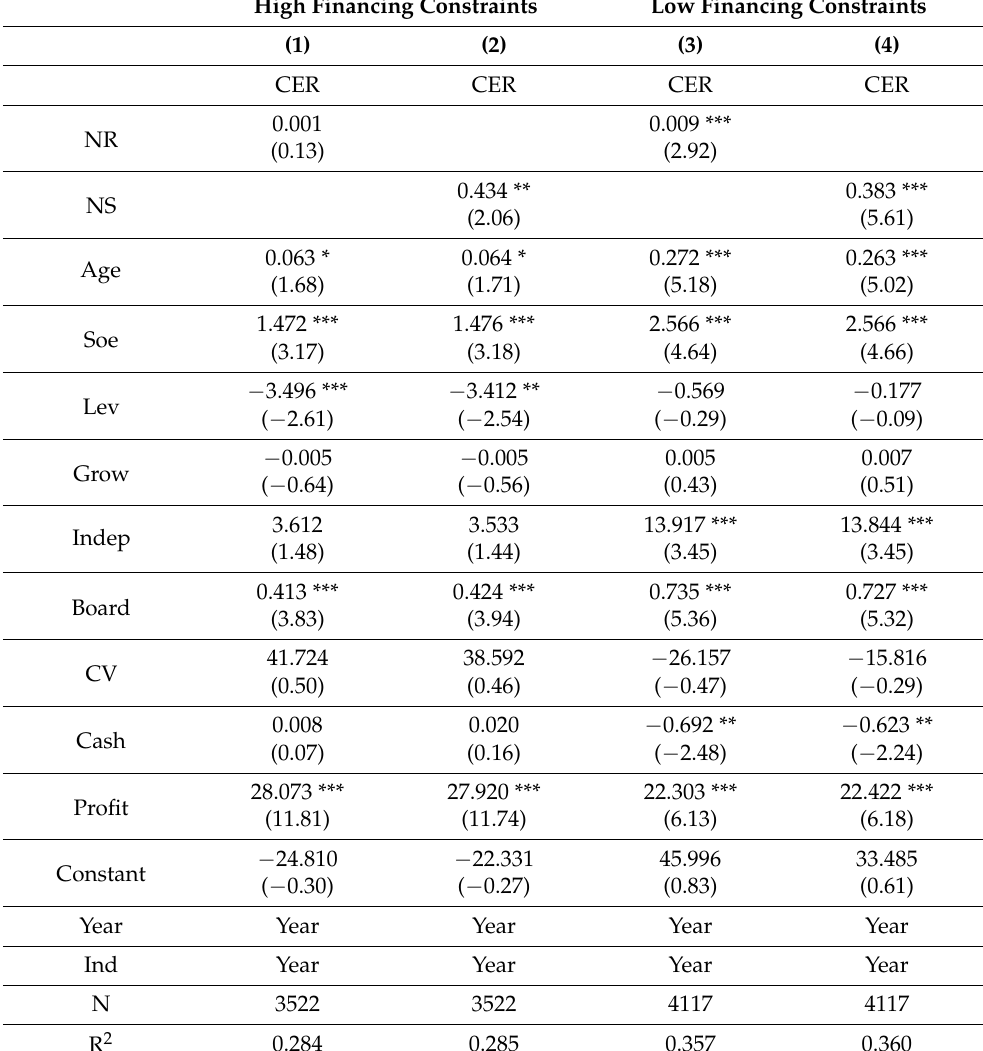
Table 11. The impact of financing